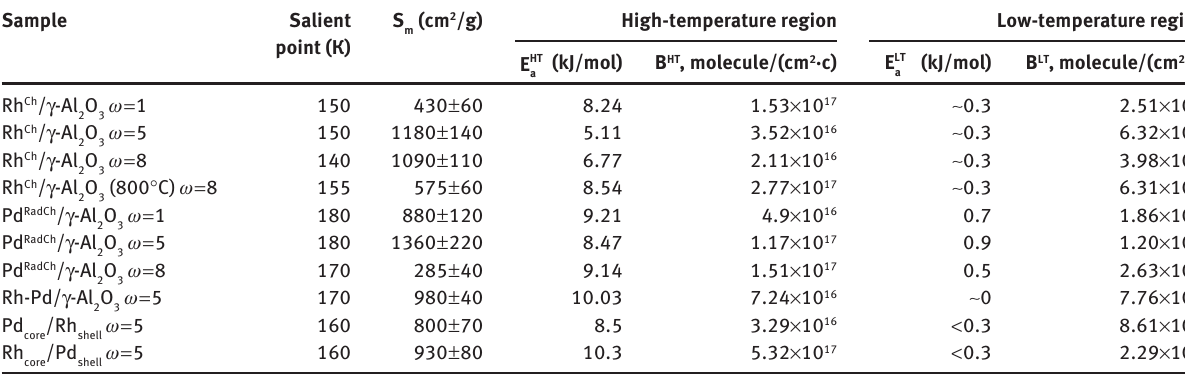
Table 2 Characteristics of the catalysts.